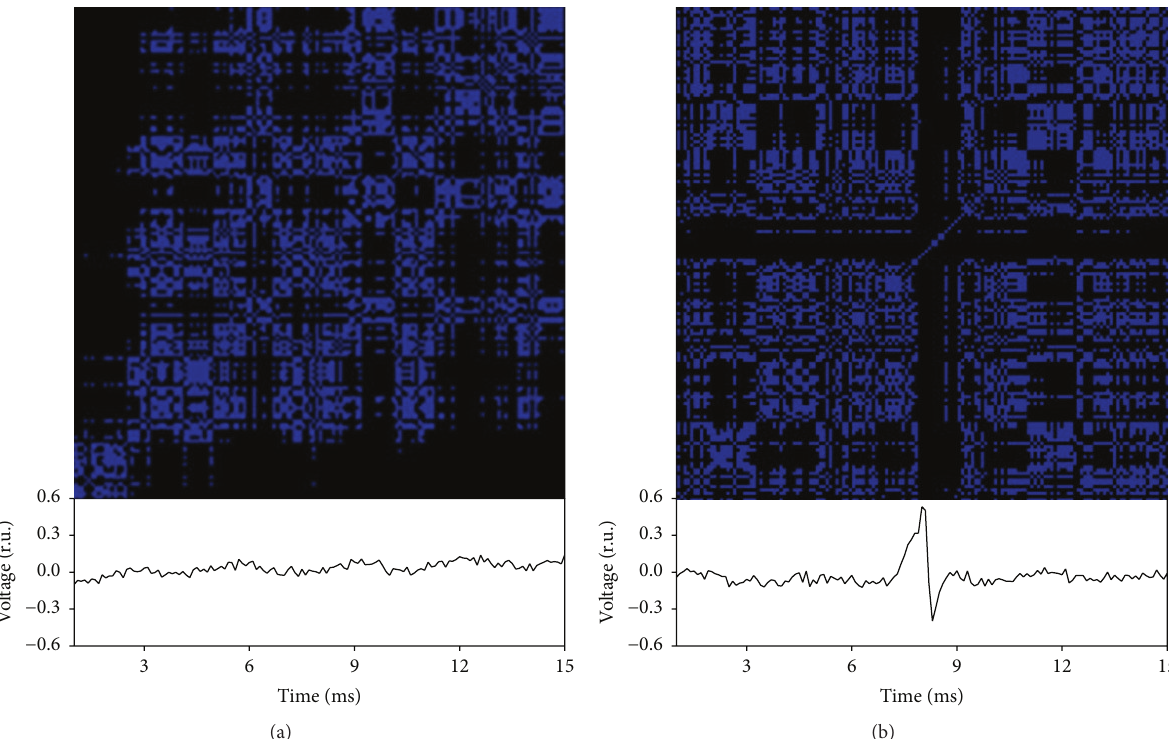
Figure 1: Recurrence plots of 15ms time periods isolated from 150ms recordings following nerve stimulation. F-waves were either absent (a) or present (b), but with different profiles when present. The recurrence plots show detailed distributions of recurrent points (blue areas) falling beneath an absolute radius threshold, namely, a predetermined threshold below which the point could be considered recurrent. Points making up the F-wave falling outside of the radius did not score recurrent points. The 𝑥 and 𝑦 axes represent time. As such for a particular point in time on the 𝑥 -axis, a blue point on the 𝑦 -axis (i.e., vertically above that time on the 𝑥 -axis) would indicate recurrence points at subsequent times in the